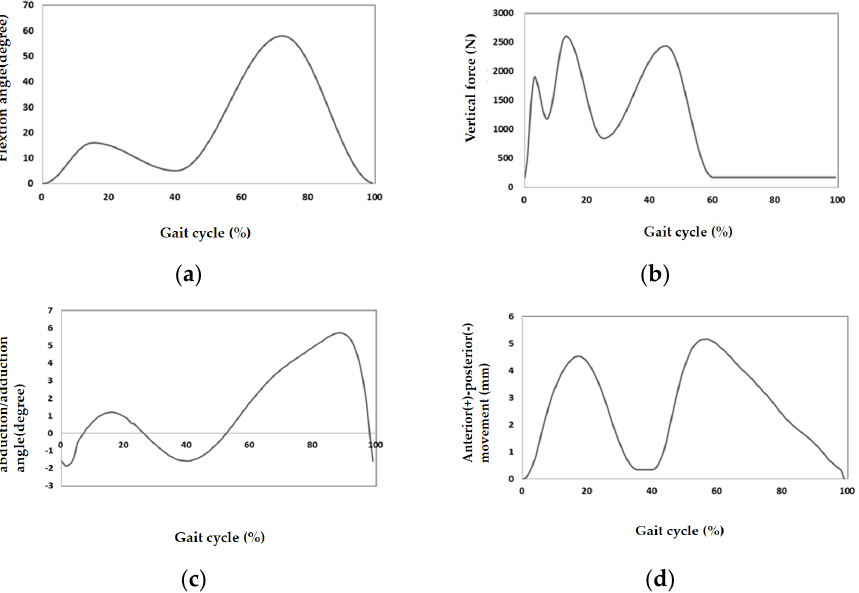
Figure 5. Input function for load and displacement conditions according to modified ISO 14243-3: ( a ) flextion–extension angle; ( b ) vertical force; ( c ) anterior–posterior displacement; ( d ) abduction– adduction angle.